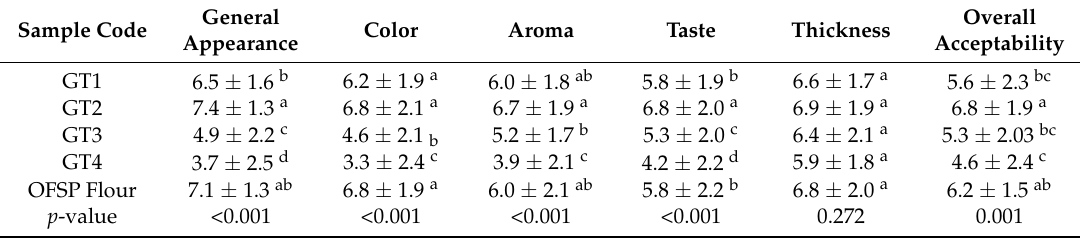
Table 7. Sensory acceptability of porridges from OFSP-based composite